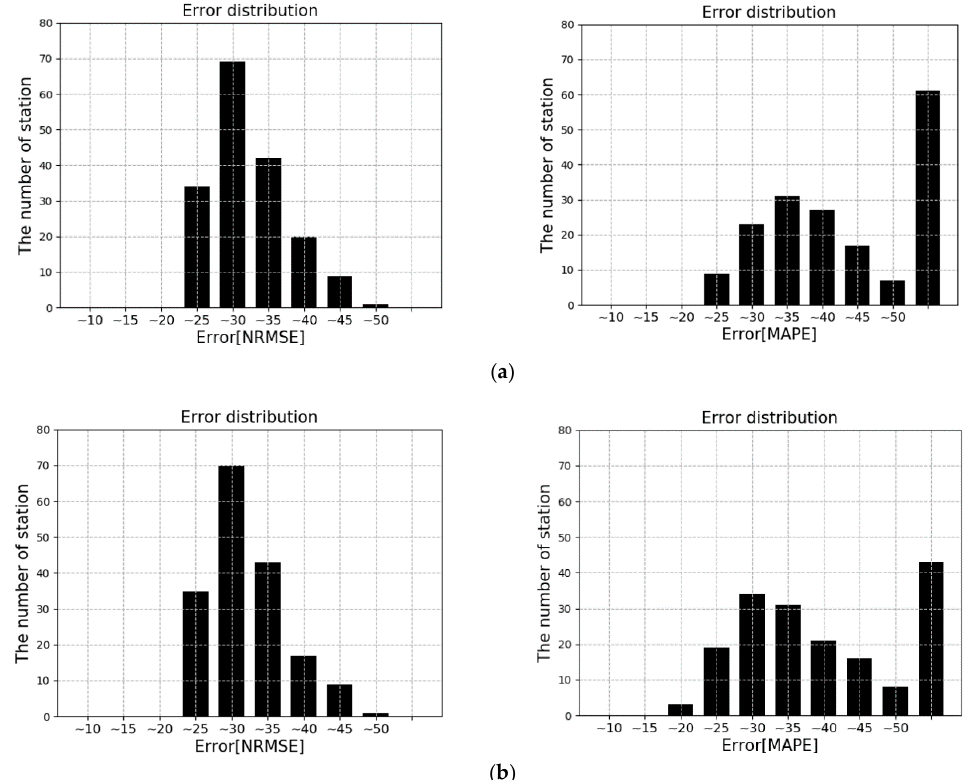
Figure 8. Graphs of electricity consumption estimation error distribution when using ( a ) the conventional linear curve and ( b ) the proposed non-linear curve.